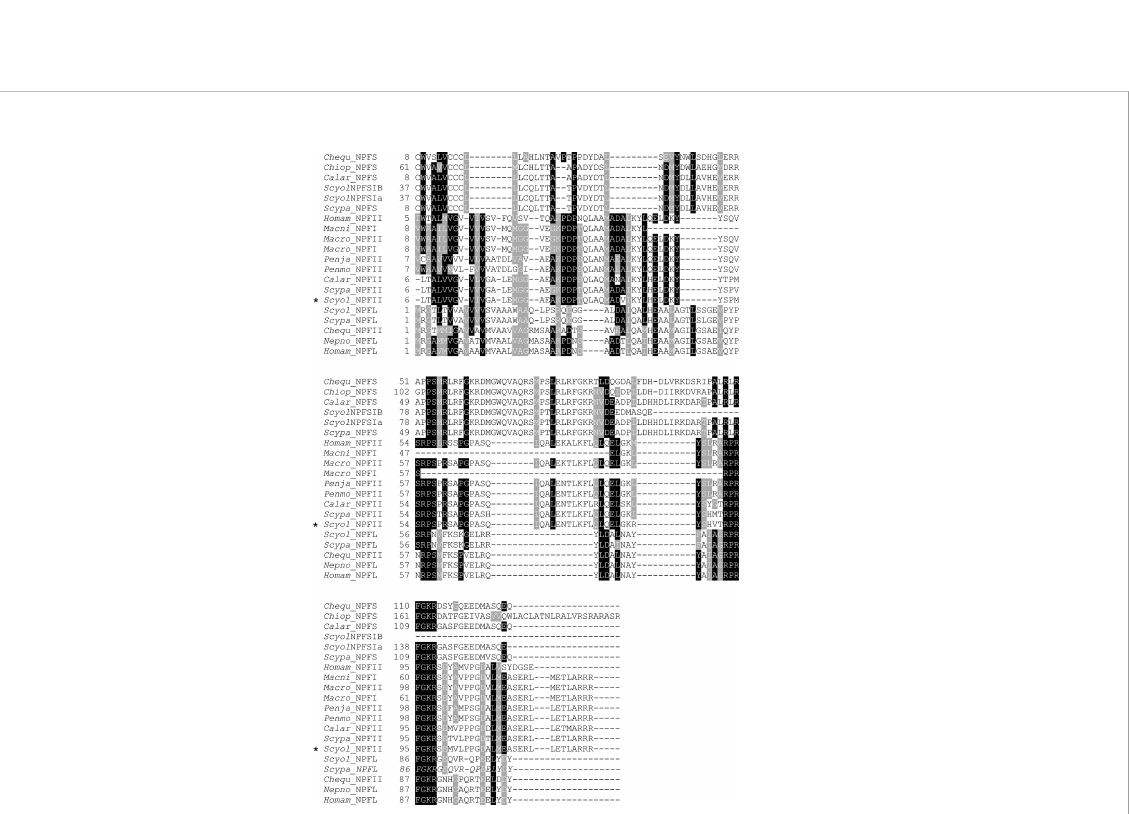
FIGURE 6 Comparative analysis of the S. olivacea NPF II protein sequence with other species. The multiple alignments of NPF II of S. olivacea proteins with NPF proteins in other species from crustaceans. Black shading in the multiple alignment indicates conserved amino acids while gray shading indicates similar amino acids. The asterisks indicate S. olivacea NPF II found in this study. Species abbreviation and GenBank accession numbers: Chequ , Cherax quadricarinatus (AWK57534.1, AWK57543.1); Chiop , Chionoecetes opilio (KAG0714693.1); Calar , Callinectes arcuatus (QPO25069.1, QPO25068.1); Homam , Homarus americanus (XP_042241562.1, XP_042234278.1); Macro , Macrobrachium rosenbergii (APP91265.1, APP91264.1); Macni , Macrobrachium nipponense (QJQ81519.1); Penja , Penaeus japonicus (XP_042870456.1); Penmo , Penaeus monodon (XM_037925377.1); Nepno , Nephrops norvegicus (QBX89063.1); Scypa , Scylla paramamosain (ALQ28587.1, ALQ28586.1, ALQ28574.1); Scyol , Scylla olivacea (ON254657, GDRN01070465, GDRN01012387,